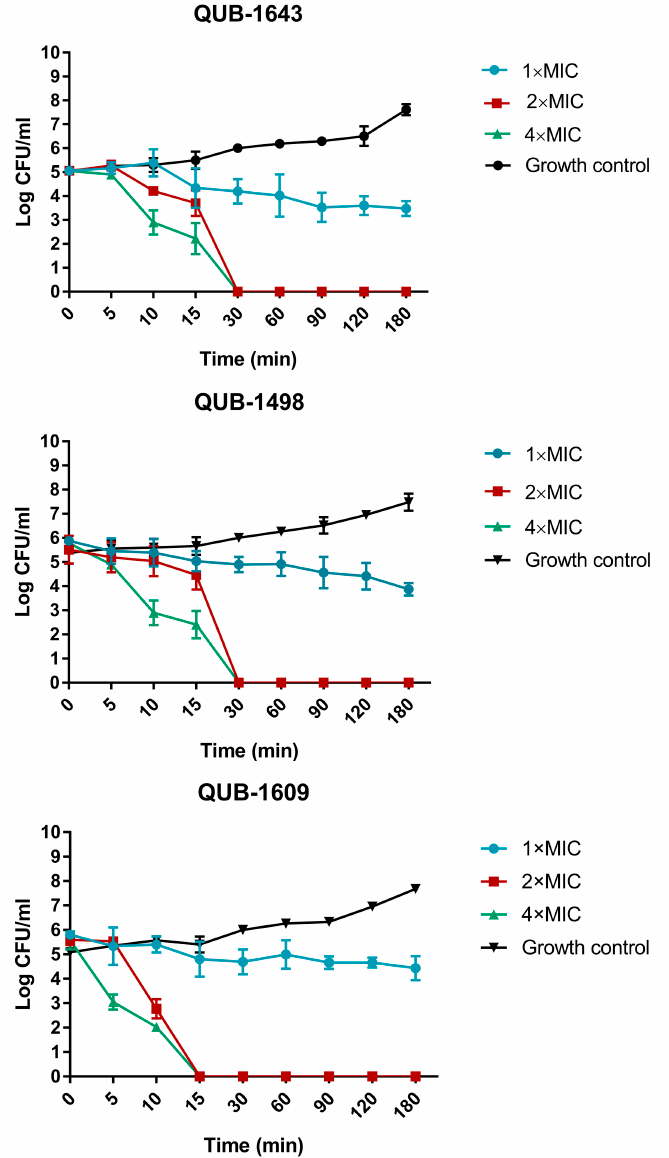
Figure 8. Time-kill line charts of kassporin-KS1 (QUB-1641) and its analogues against S. aureus . The logarithmic values of colony-forming units (CFU) at 0, 5, 10, 15, 30, 60, 90, 120, and 180 min were reflected on the y-axis. The growth control was the bacterial-medium suspension at the same time point. Error bars represent the standard error of the average number of microbial cells measured in CFU/mL at each time point (based on five replicates).